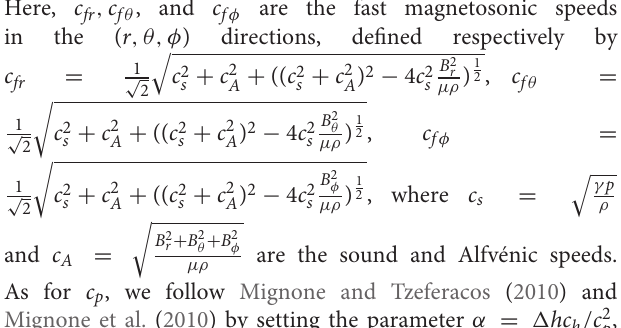
Frontiers in Astronomy and Space Sciences |